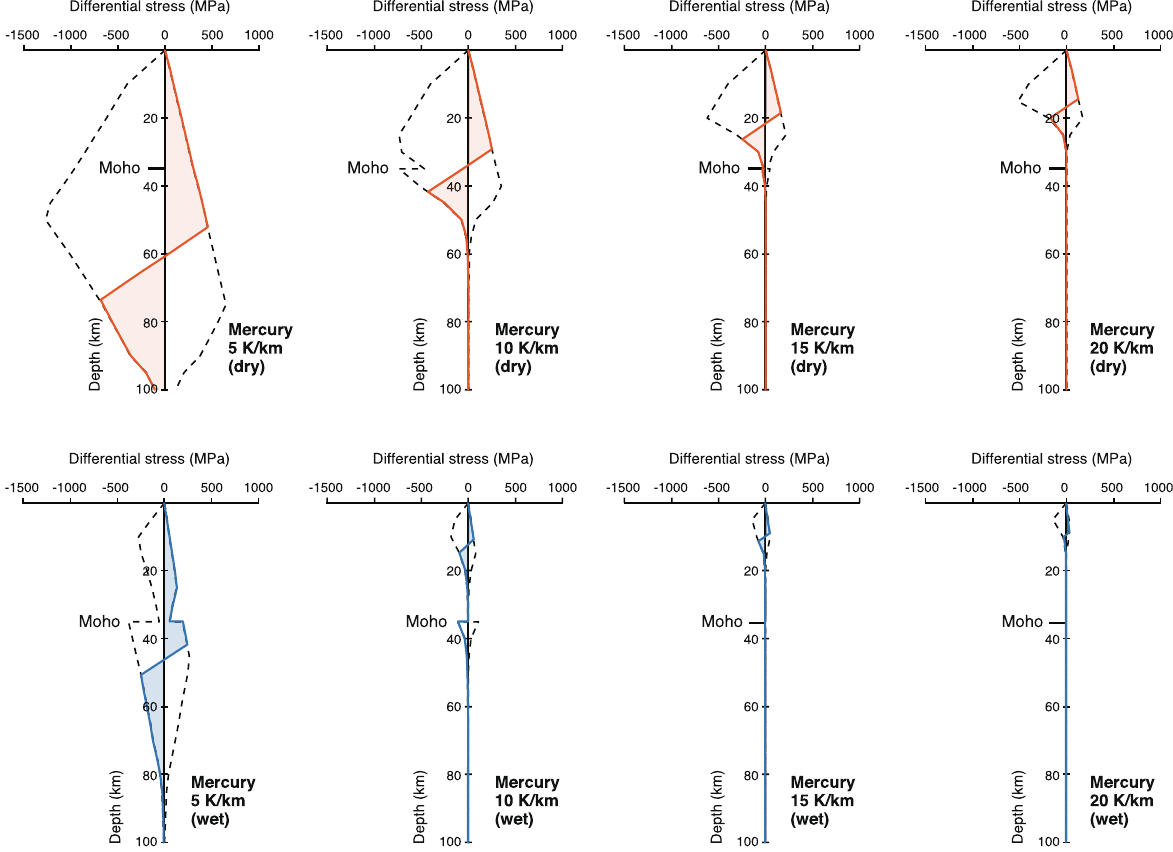
Fig. 4 Strength profiles for Mercury with variable thermal gradients under dry (upper panel) and wet (lower panel) conditions. Brittle strength is calculated from Byerlee ’ s law, and plastic strength is calculated from flow laws using a constant strain rate of 10 − 17 s − 1 . The stress state assumes tensional deformation at shallow depths that shifts to compression at greater depths. A flexural curvature of 5 × 10 − 7 m − 1 was used for calculations. The red/blue shading indicates the bending moment, which is balanced between tensional and compressional forces within the lithosphere